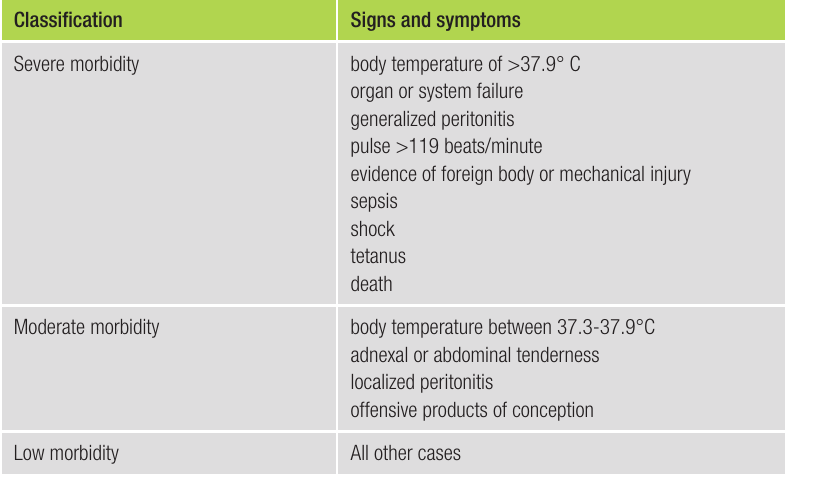
Table 7 Classification of severity categories of abortion